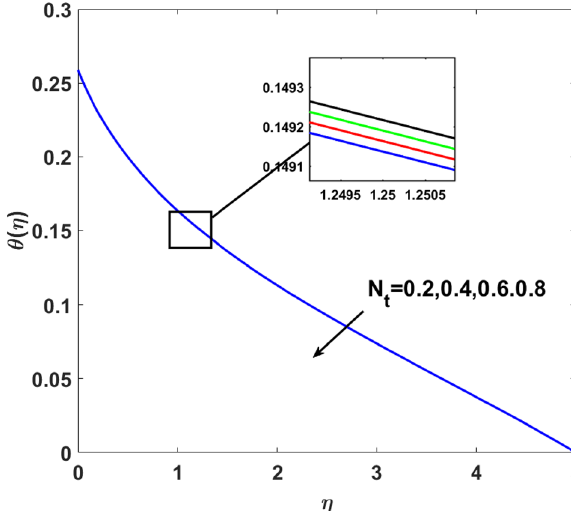
Figure 11. θ(η) versus N t